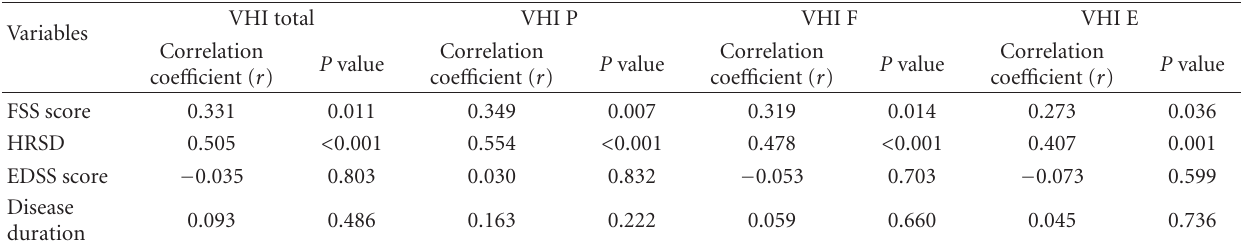
Table 3: Association of VHI scores with selected variables among cases.